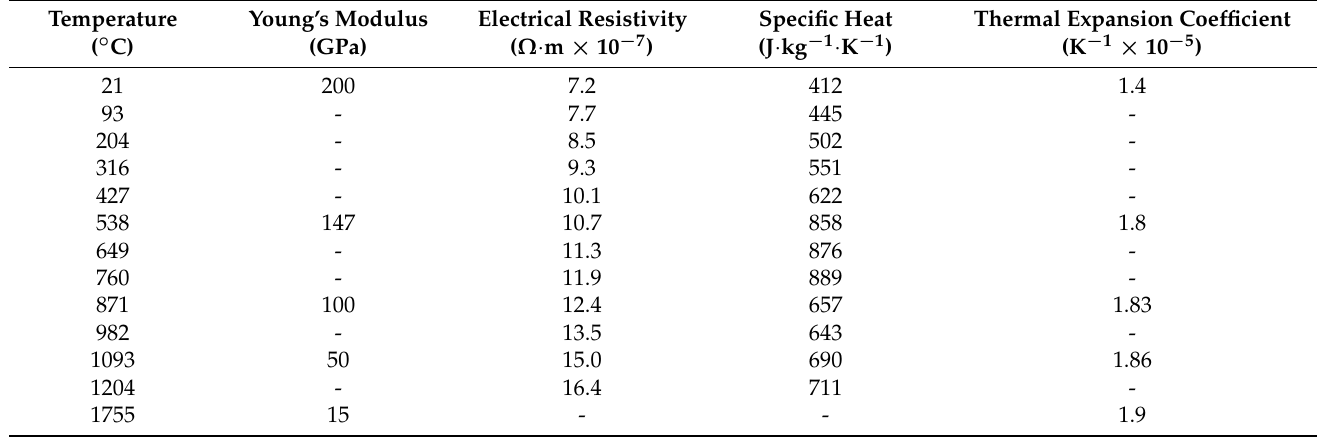
Table A3. Thermo-physical properties of the AISI304 stainless steel.